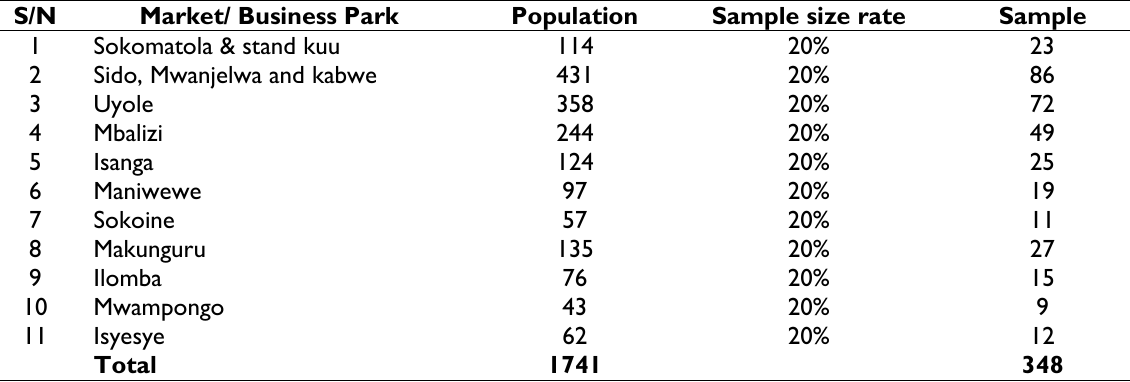
Table 1. Sampling Distribution among Markets/ Business